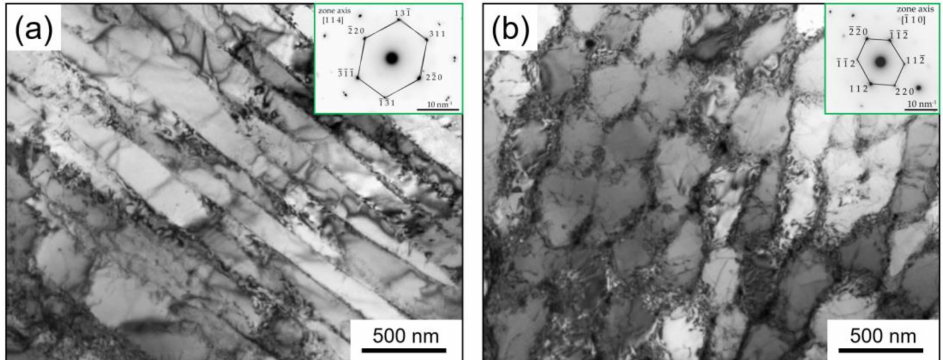
Figure 10. TEM bright field images showing ( a ) columnar and ( b ) equiaxed cellular substructure in as-built Inc718 sample produced by micro-LPBF. Inserts show the corresponding SAD patterns.